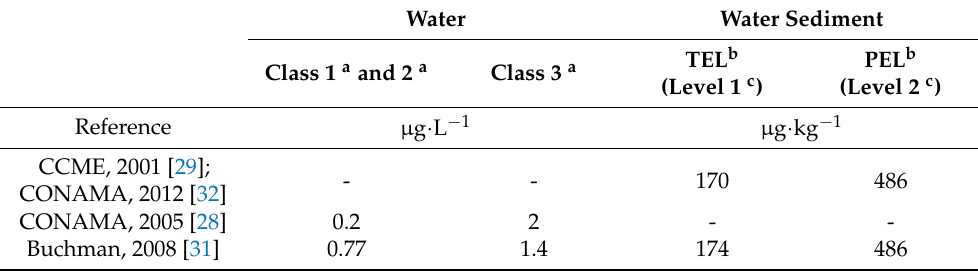
Table 2. Lower and upper limits of Hg concentration for sediment and water according to national and international standards.